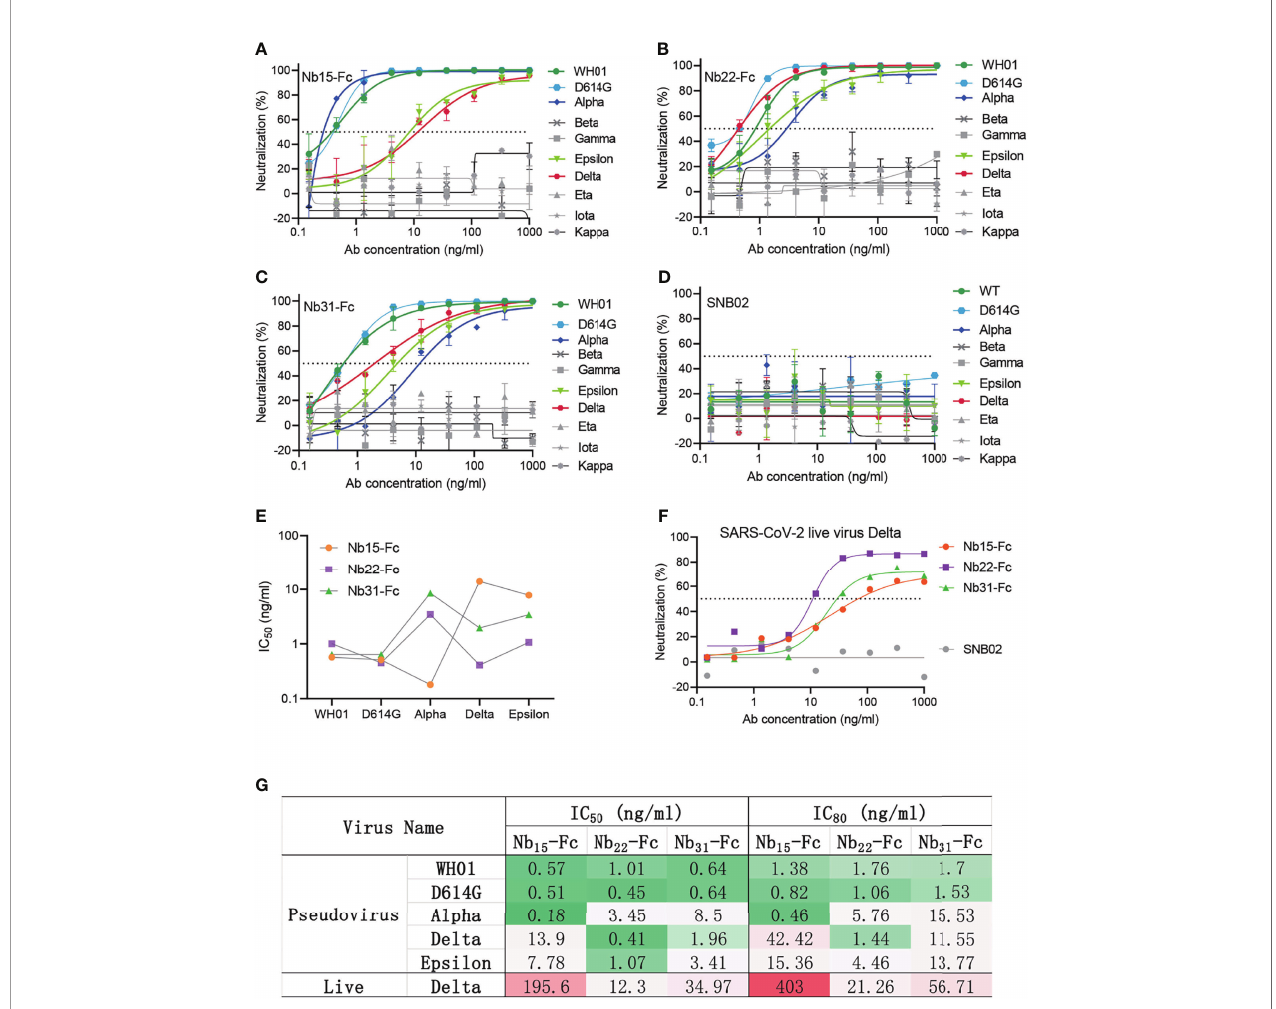
FIGURE 1 | Characterizing nanobodies neutralizing circulating variants of SARS-CoV-2. The neutralization curve of Nb15-Fc (A) , Nb22-Fc (B) , Nb31-Fc (C) , and SNB02 (D) inhibiting SARS-CoV-2 pseudovirus of circulating variants. Nb-Fcs and SNB02 were all constructed as the format of VHH fused with human Fc1. SNB02 was taken as an antibody control speci fi c for SFTS virus. (E) The summary curve of IC 50 of Nb-Fcs exhibiting potent neutralization against SARS-CoV-2 variants. (F) The neutralization potency of Nb-Fcs was evaluated based on authentic SARS-CoV-2 Delta variant plaque reduction neutralization test. (G) The summary table of IC 50 and IC 80 of Nb-Fcs in panels (A – C, F) , displaying potent neutralization. Data are represented as mean ± SD. All experiments were repeated at least